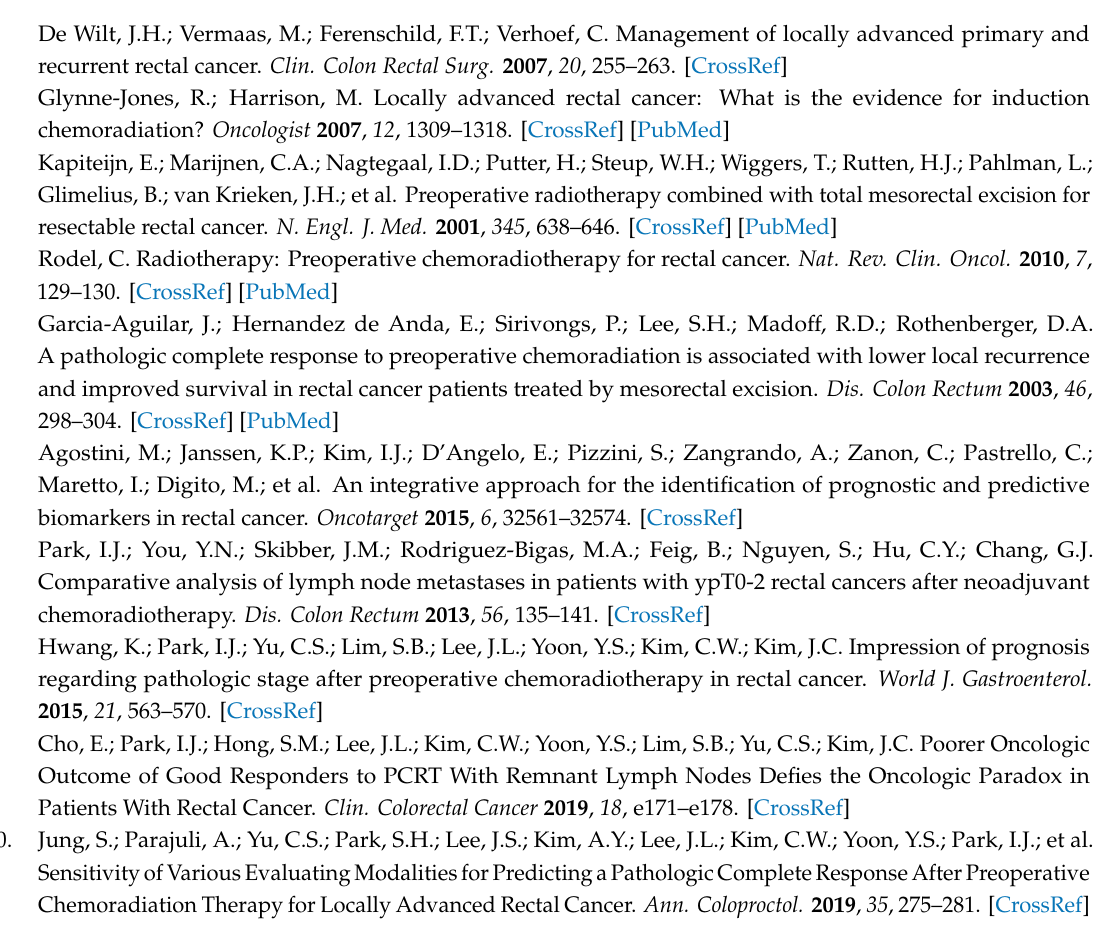
Figure S1: Metadata analysis-based PCRT responder gene signature related pathway: PI3K-Akt signaling pathway, Figure S2: PI3K-Akt signaling pathway three-dimensional genomic expression map for PCRT responders based on metadata analysis, Table S1: Di ff erentially expressed genes between responders and non-responders in the training cohort, Table S2: Gene signature